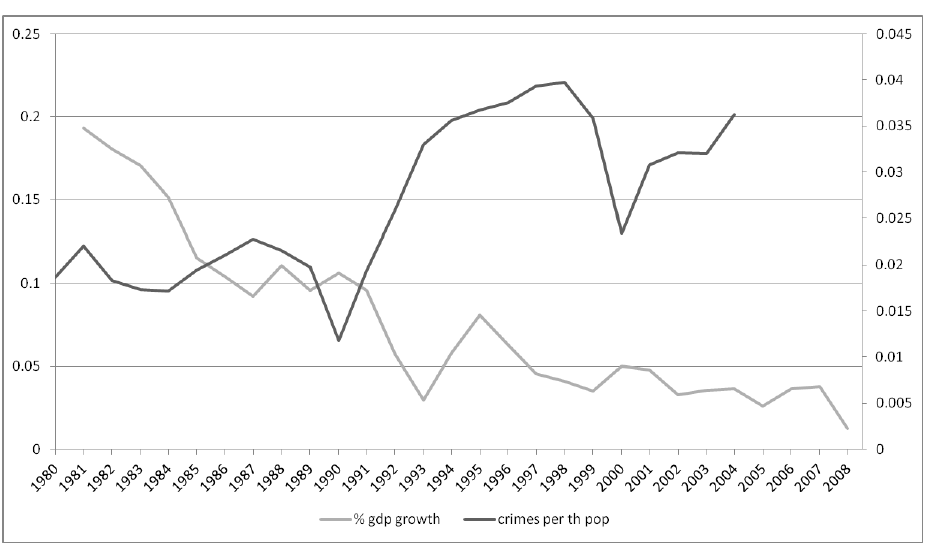
Figure 1: Time dynamics of GDP growth and per capita corruption crimes